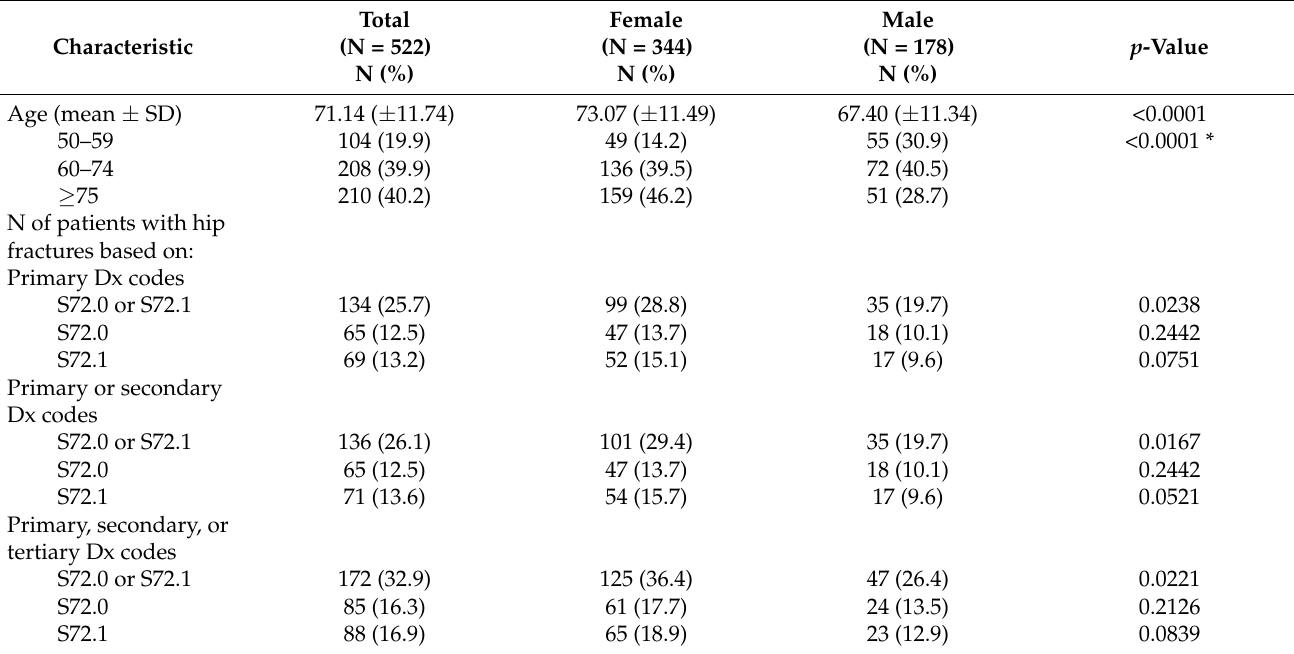
Table 1. Patients’